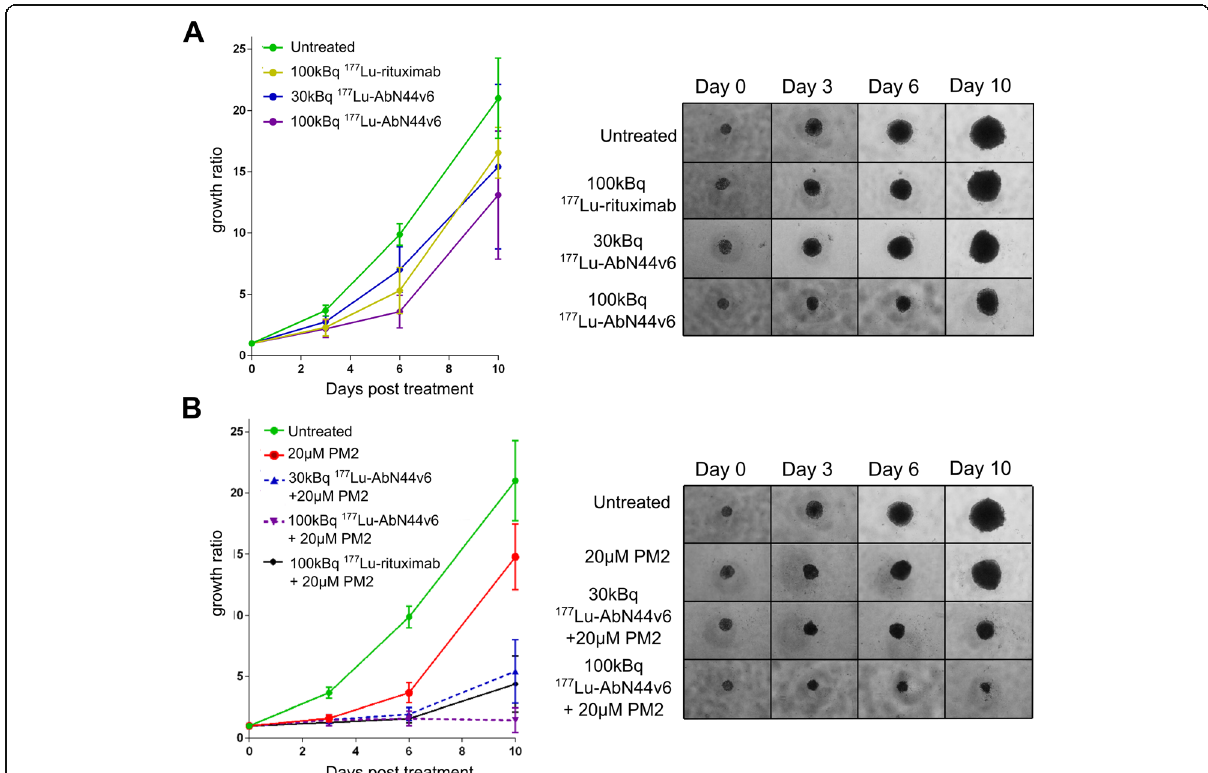
Fig. 4 a UM-SCC-74B spheroid growth over time after treatment with 30 kBq and 100 kBq 177 Lu-AbN44v6 and 100 kBq 177 Lu-rituximab as well as representative images of treated spheroids. b UM-SCC-74B spheroid growth over time after treatment with 20 μ M of PM2 and the combination of 20 μ M PM2 with 30 kBq and 100 kBq 177 Lu-AbN44v6 and 100 kBq 177 Lu-rituximab as well as representative images of treated spheroids. n ≥ 4, error bars presented as 95% confidence intervals. A combination of 20 μ M PM2 with 30 kBq 177 Lu-AbN44v6 differed significantly